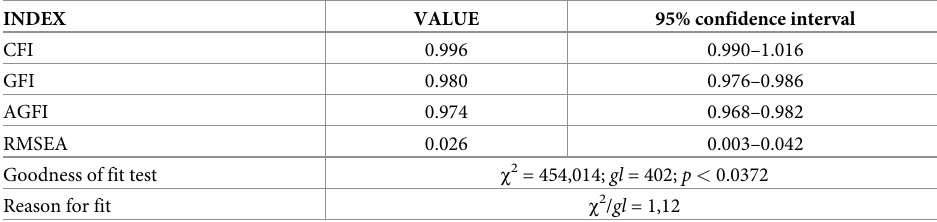
Table 3. Indexes of goodness of fit of the exploratory factor analysis of the model for four dimensions the